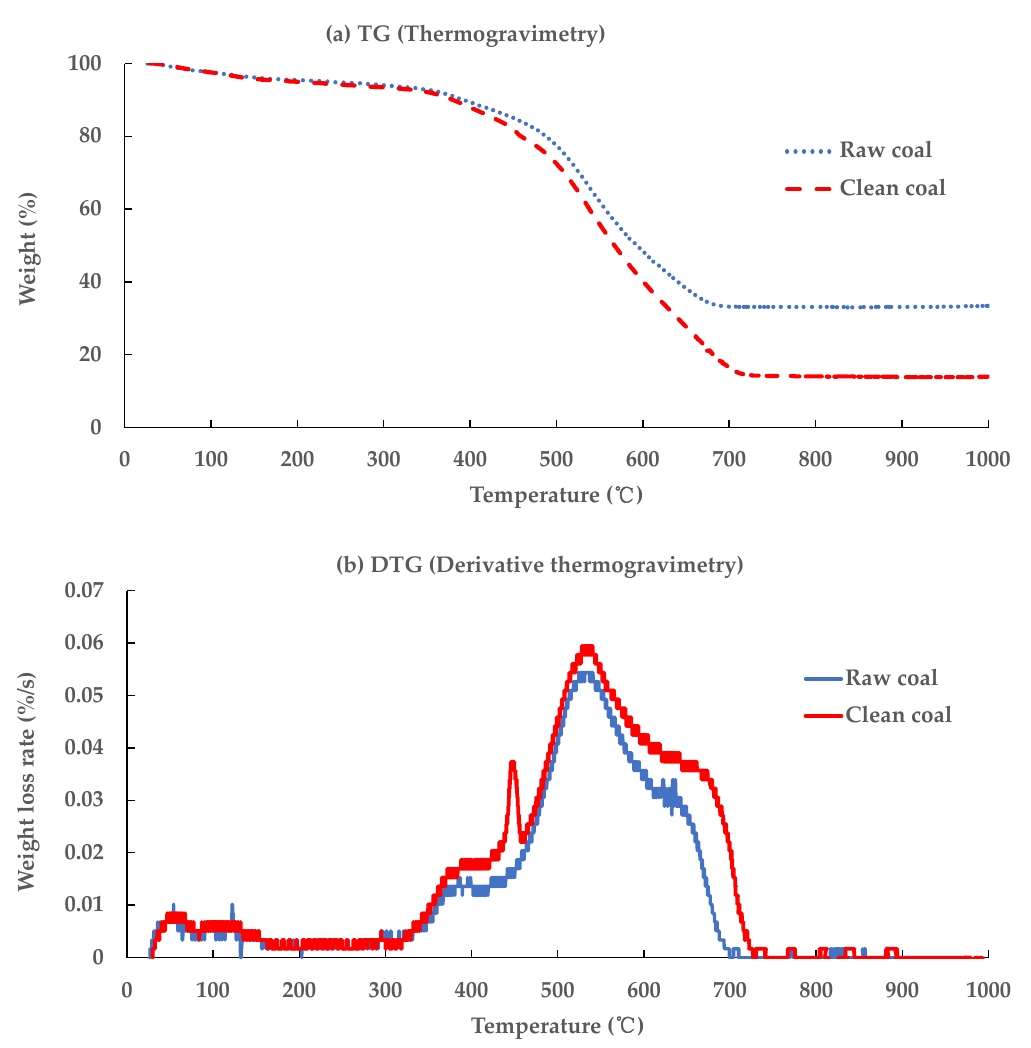
Figure 11. Combustion behavior of the raw coal and its clean coal using a dry coal cleaning system with two-stage corona electrostatic processes. ( a ) TG (thermogravimetry); ( b ) DTG (derivative thermogravimetry).